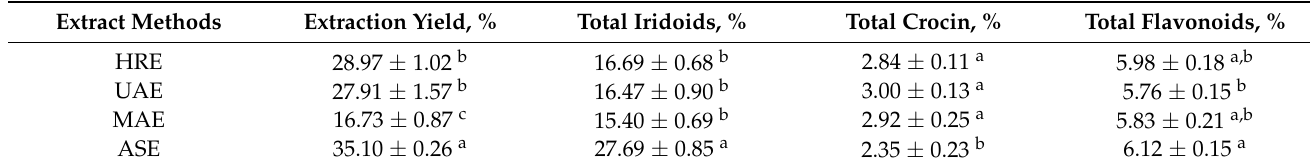
Table 4. Effect of extract methods on the yield and the active components’ content in the Gardeniae fructus extract ( n = 6). Extract